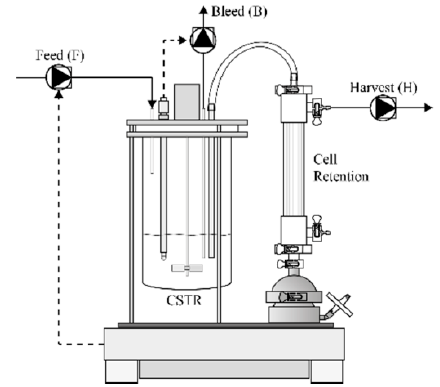
Figure 2. A schematic of perfusion cell culture reactor (Figure adapted from [39] with the permission from the authors). CHO cells were cultivated in suspension in a continuous stirred tank reactor with continuous feeding of fresh nutrients. Cell-free spent media was constantly collected in the harvest stream, while cells remained in the stirred tank reactor. A bleed stream removed a small fraction of the reactor mixture, including biomass, which was used to regulate viable cell density.